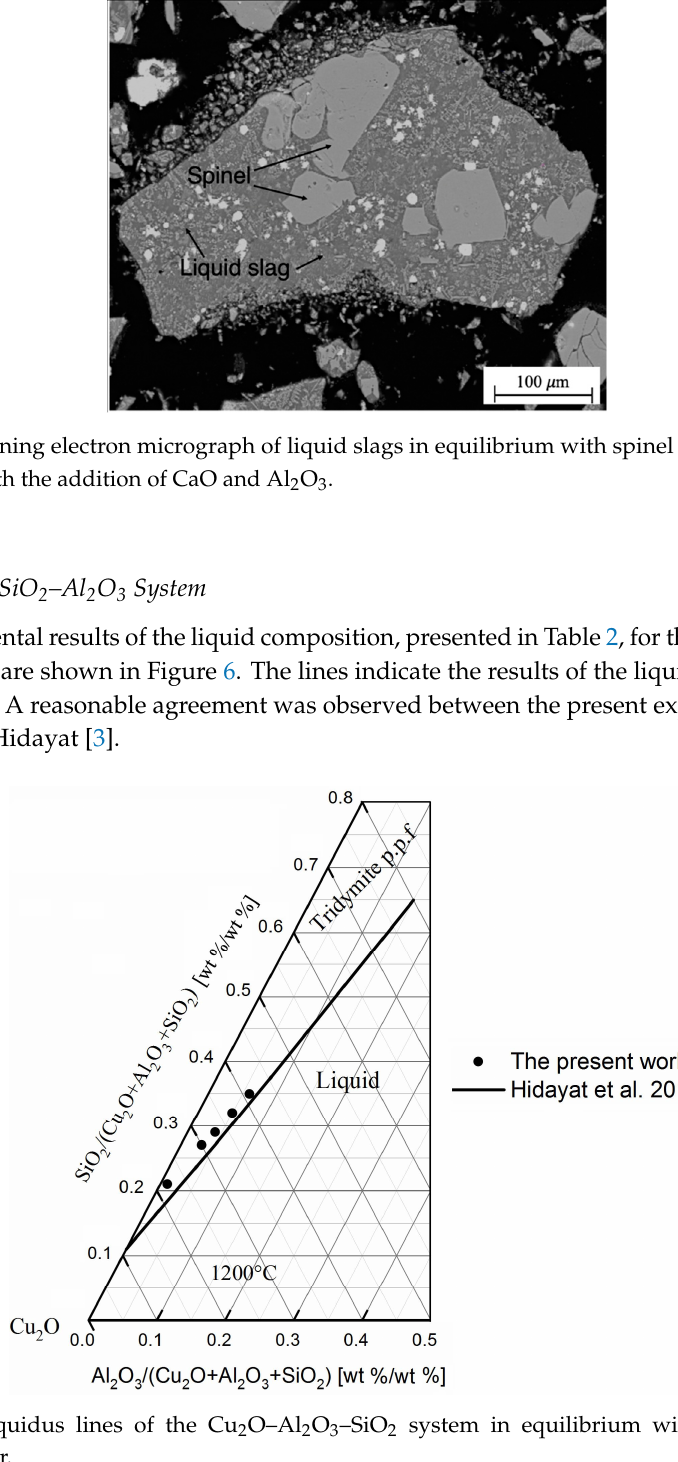
Figure 6. Liquidus lines of the Cu 2 O–Al 2 O 3 –SiO 2 system in equilibrium with tridymite and metallic